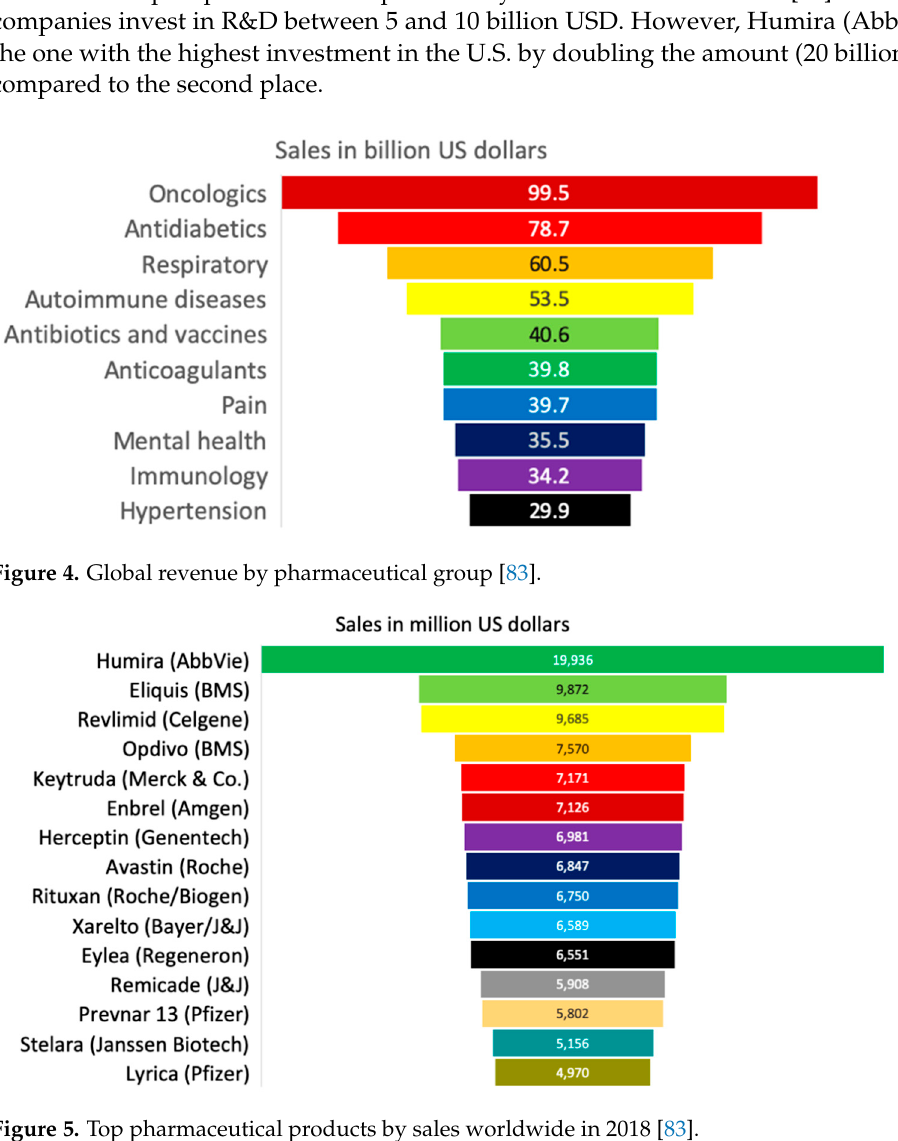
Figure 5. Top pharmaceutical products by sales worldwide in 2018 [83].